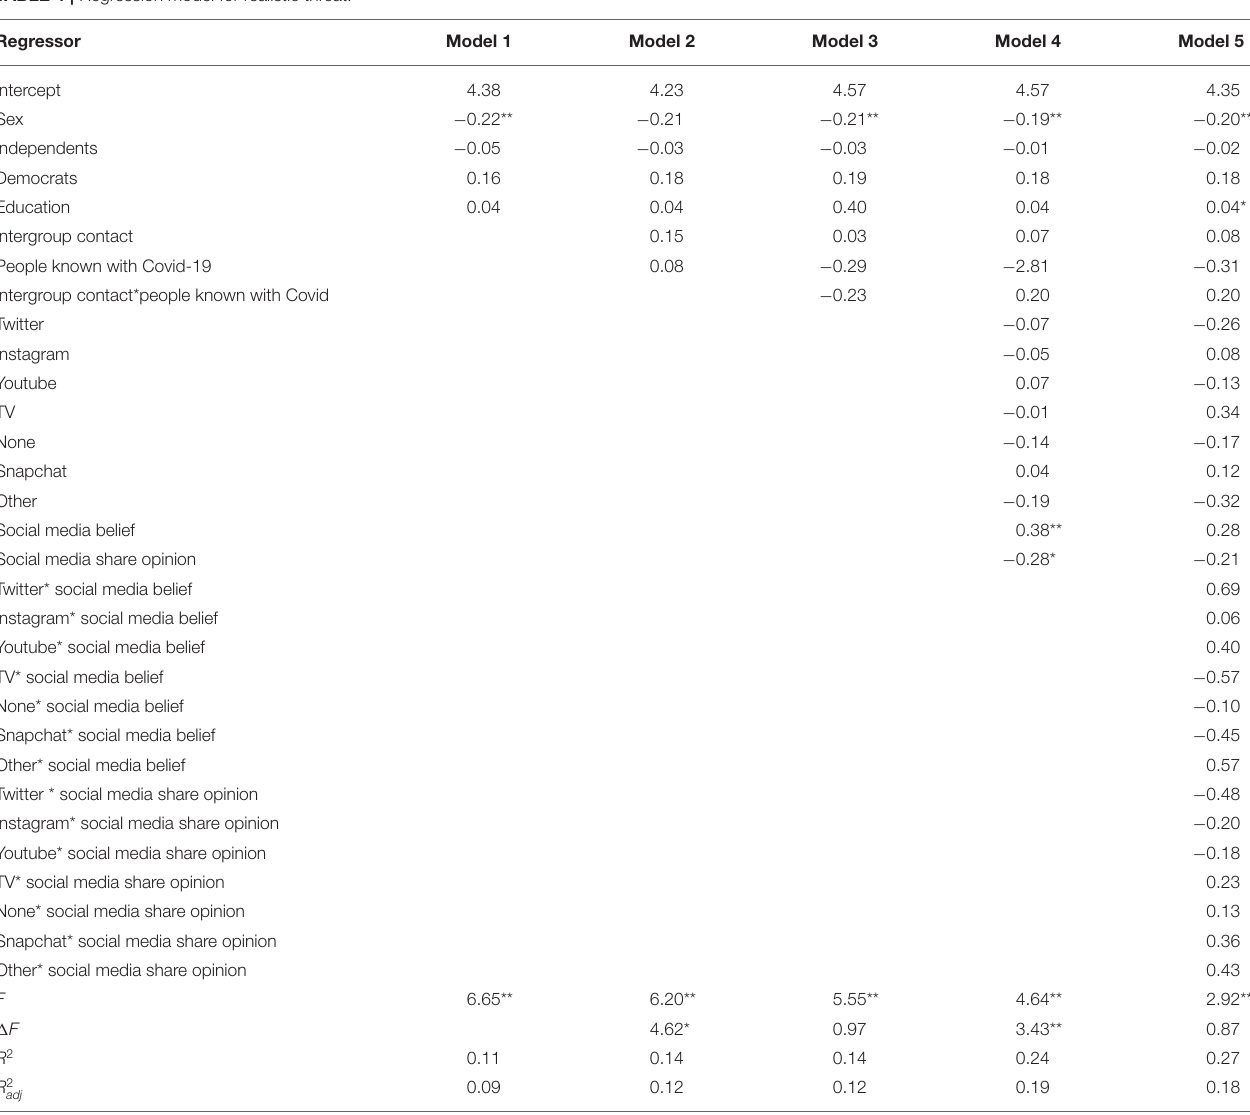
TABLE 4 | Regression model for realistic